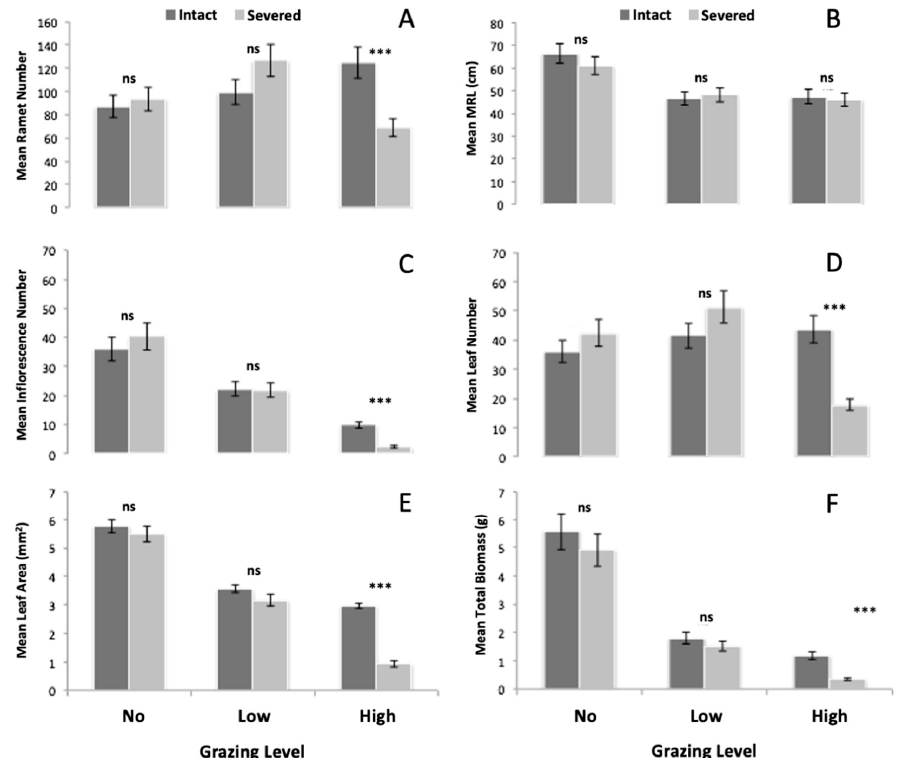
Figure 2. Effects of grazing and integration on mean ramet number ( A ), main rhizome length (MRL) ( B ), inflorescences ( C ), leaf number ( D ), leaf area ( E ), and total biomass ( F ) for each treatment, with least squares means simple effect comparisons and (+/ − ) standard error bars. Symbols show which means differed between integration treatments for all three grazing levels. Significance levels indicated by ns p > 0.05; *** p < 0.001.